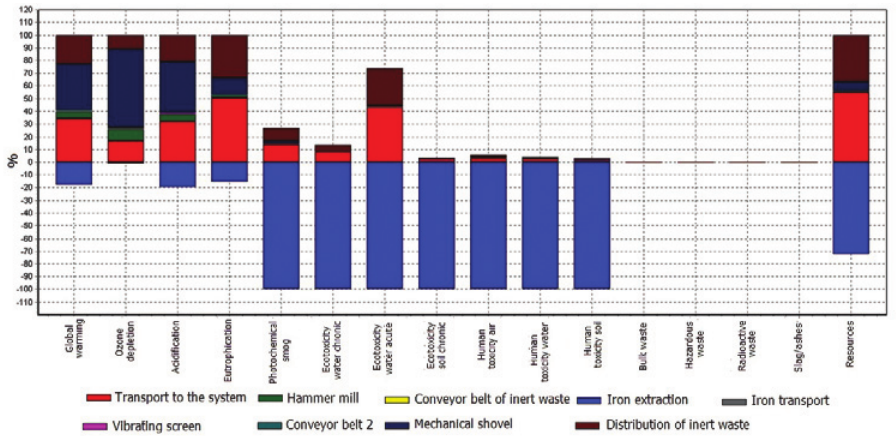
Fig. 15. Characterization of impacts generated in various phases of C&DW recycling/reuse process assessed with the EDIP/UMIP